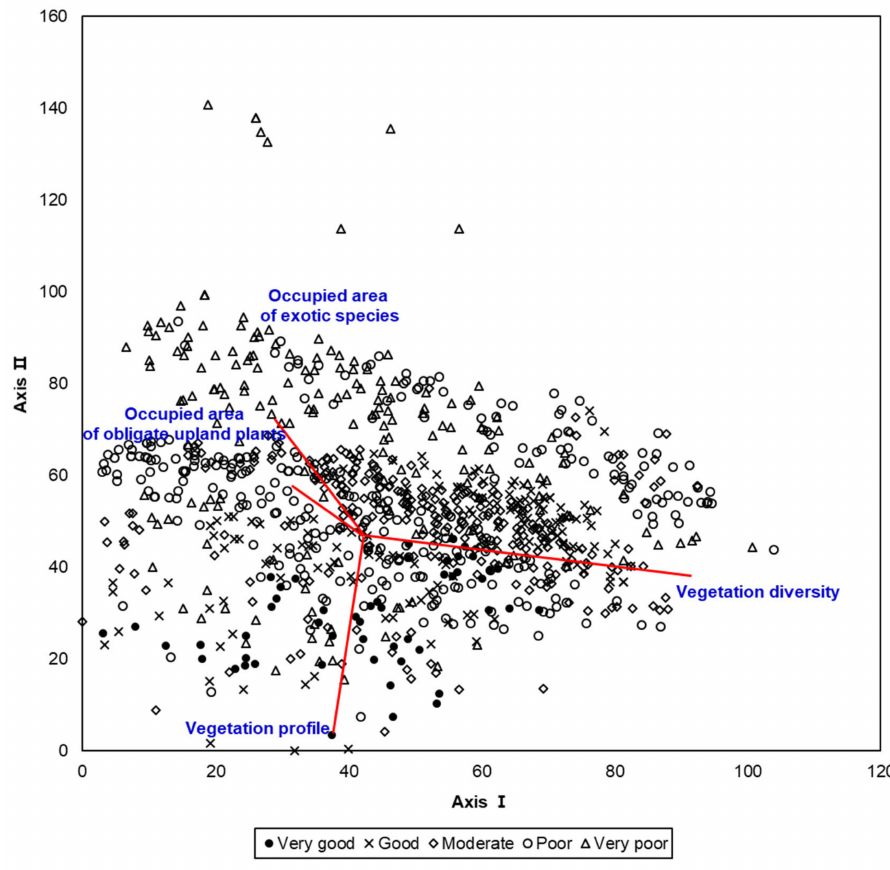
Figure 2. Stand ordination of 960 reaches, which were evaluated based on the riparian vegetation